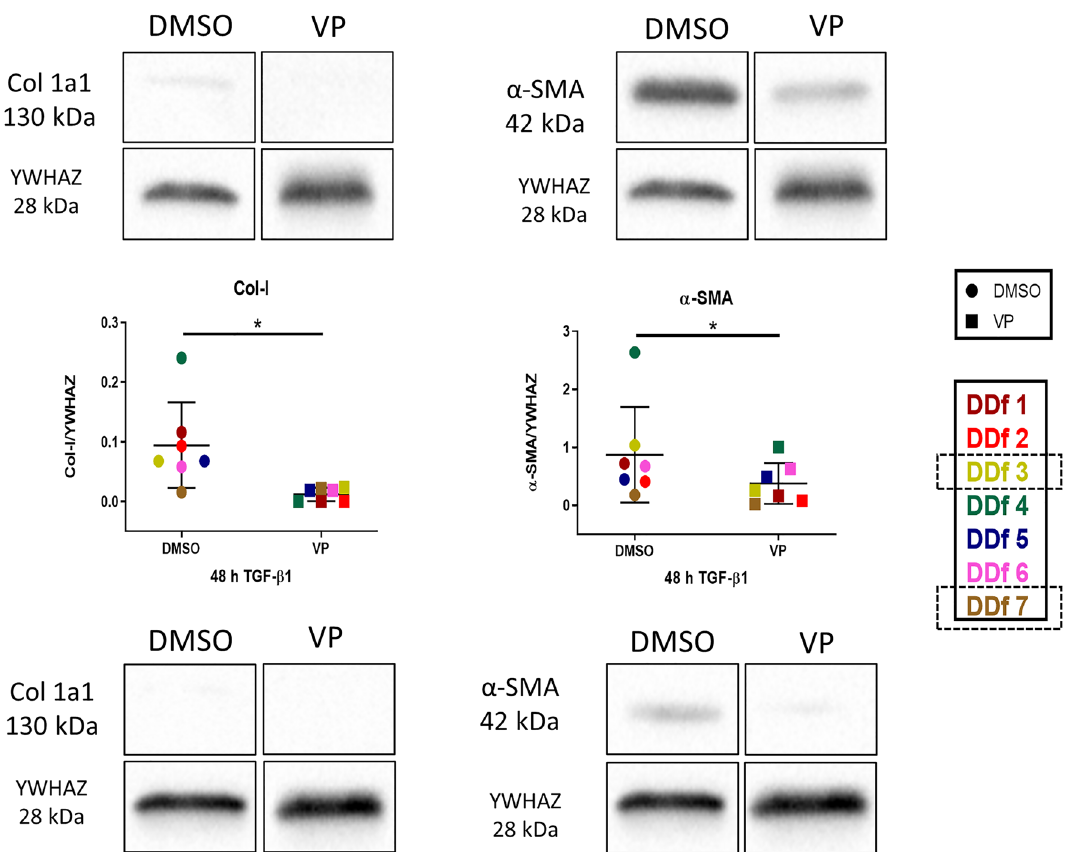
Figure 6. Western blot analysis and quantification of Col 1a1 and α-SMA in DD nodule-derived fibroblasts after stimulation for 48 h with TGF-β1 followed by 48 h in the presence or absence of VP. Images from donors with high and low expression (high: patient DDf3 and low: patient DDf7). Original blots are presented in Supplementary Fig. 1